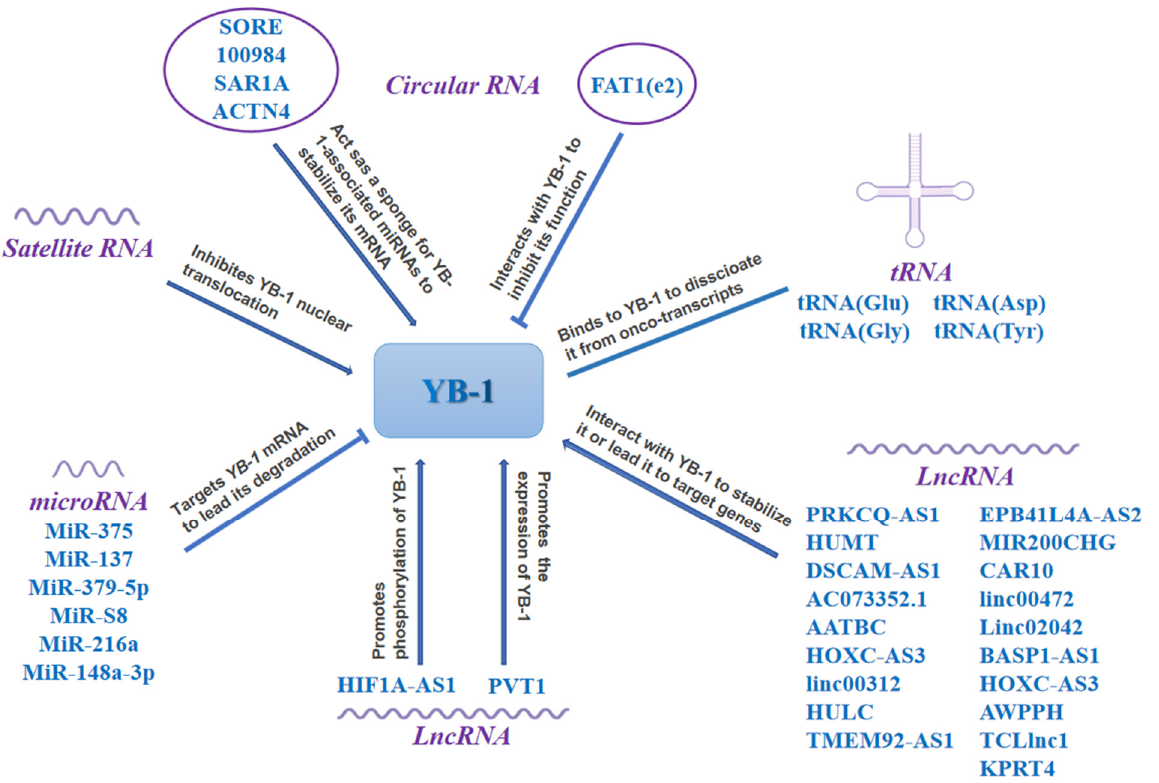
Figure 3. Multiple types of RNA regulate YB-1 expression or function. RNAs, including lncRNA, tRNA, microRNA, circular RNA, and satellite RNA, can regulate YB-1 expression at the pro- tein/mRNA level, or influence YB-1 subcellular localization or phosphorylation. Picture resources are partly from https://www.figdraw.com/, accessed on 17 March